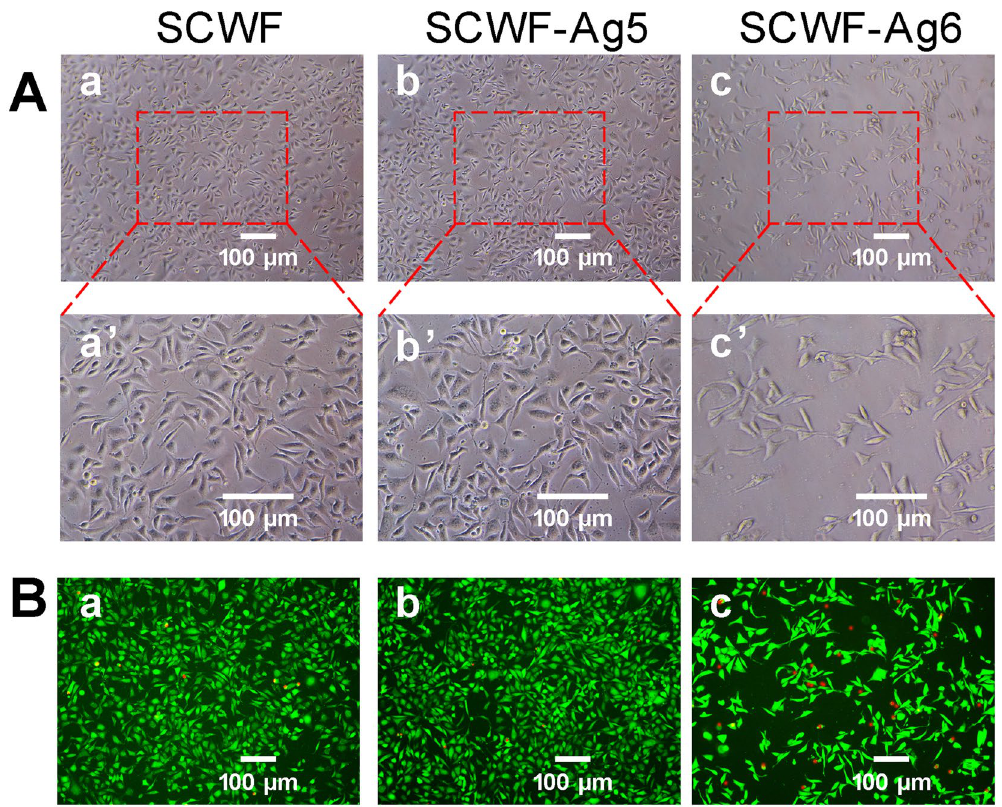
Figure 6. ( A ) Growth observations of L929 cells treated with SCWF (a,a’), SCWF-Ag5 (b,b’), and SCWF-Ag6 (c,c’). ( B ) Calcein-AM/PI Double Stain Kit assay of L929 cells upon treatment with SCWF (a), SCWF-Ag5 (b) and SCWF-Ag6 (c). Live cells are stained by Calcein AM dye and produce an intense uniform green fluorescence (ex/em ~495 nm/~515 nm). Dead cells are stained by Calcein PI dye and emit bright red fluorescence (ex/em ~495 nm/~635 nm). The scale bar represents 100 μ